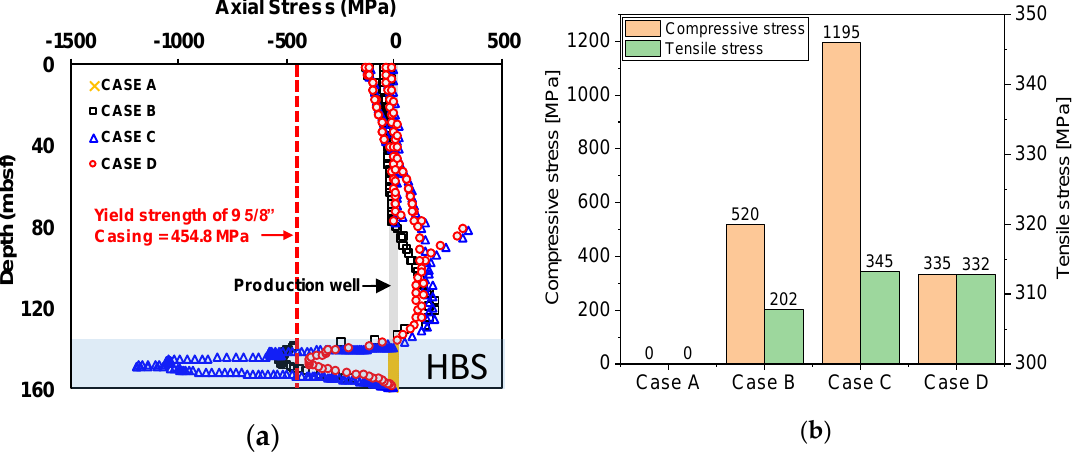
Figure 14. Results of parametric analyses: ( a ) Distribution of axial stress; ( b ) the maximum axial stresses.